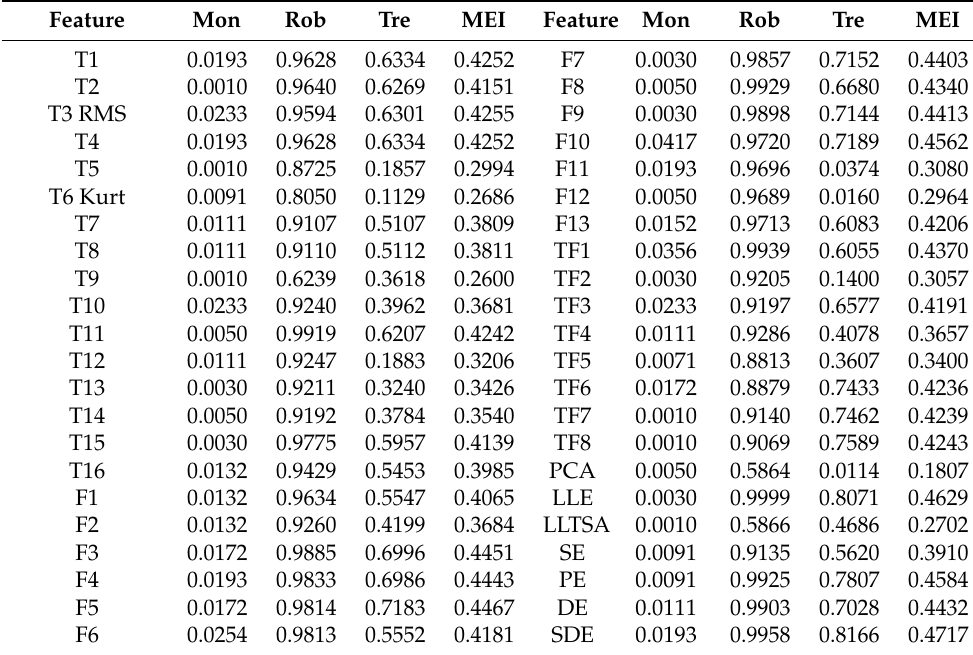
Table 1. The evaluation results of bearing fault state